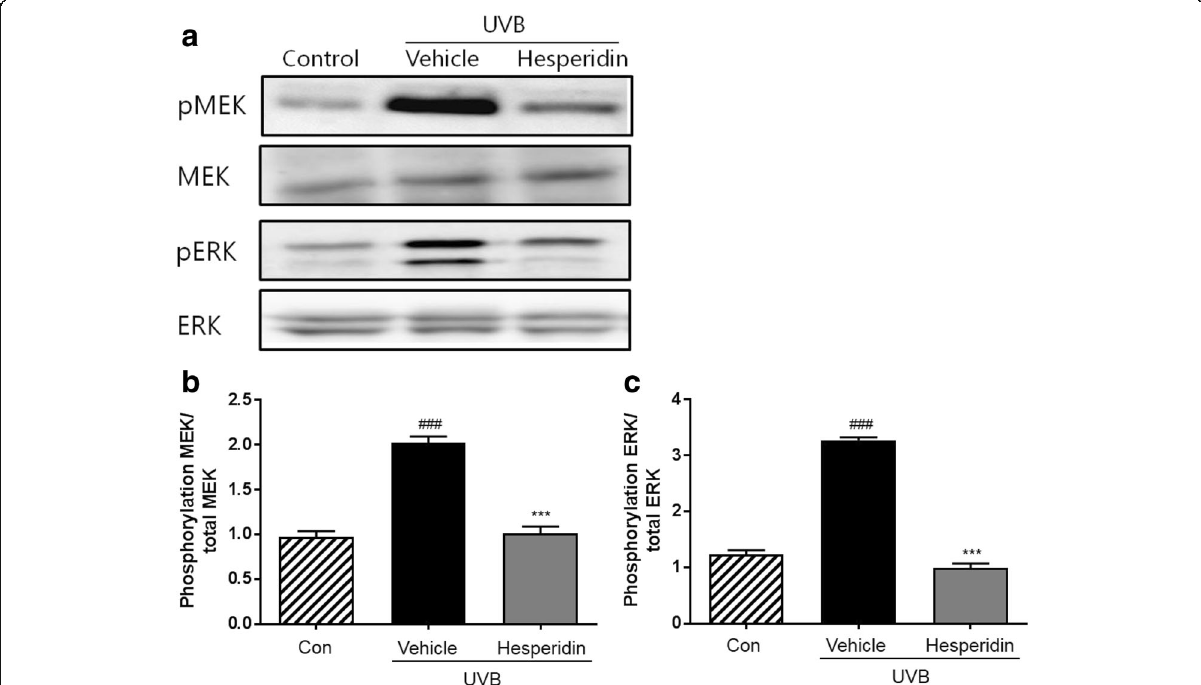
Fig. 6 Effects of hesperidin on the phosphorylation of MEK and ERK in the UVB-irradiated mice model. ( a ) Hesperidin inhibited the phosphorylation of MEK and ERK. Western blot analyses of phospho-MEK, MEK, phospho-ERK, and ERK expression were performed. Quantitative analysis of intensity was performed by Image J software on ( b ) phospho-MEK and ( c ) phospho-ERK. ### P <0.001 significant difference from control and *** P <0.001 significant difference from UVB/vehicle